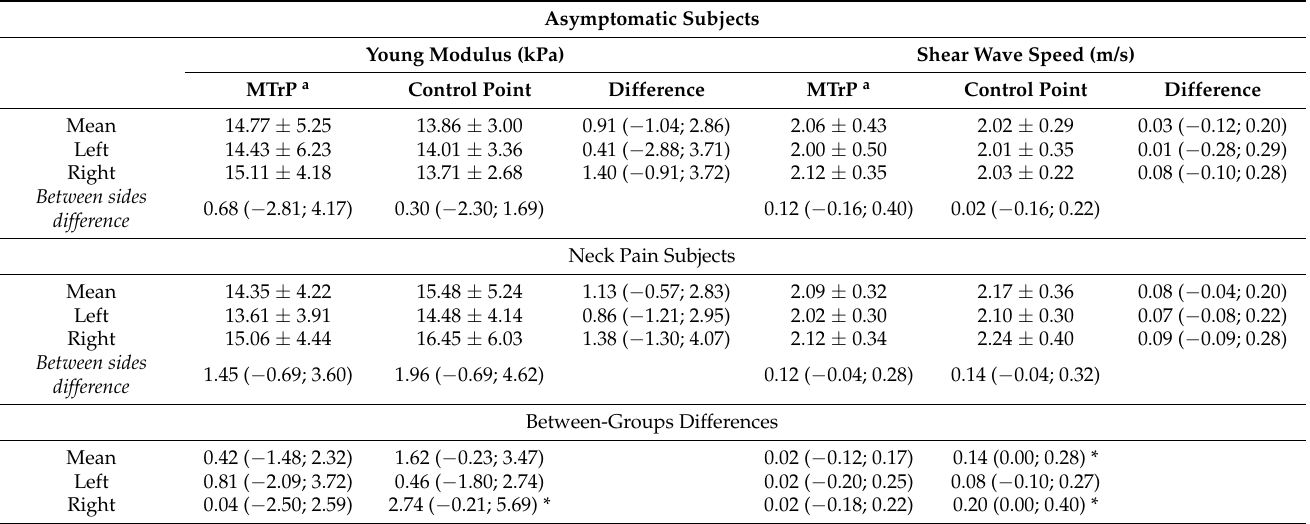
Table 3. Shear Wave Elastography